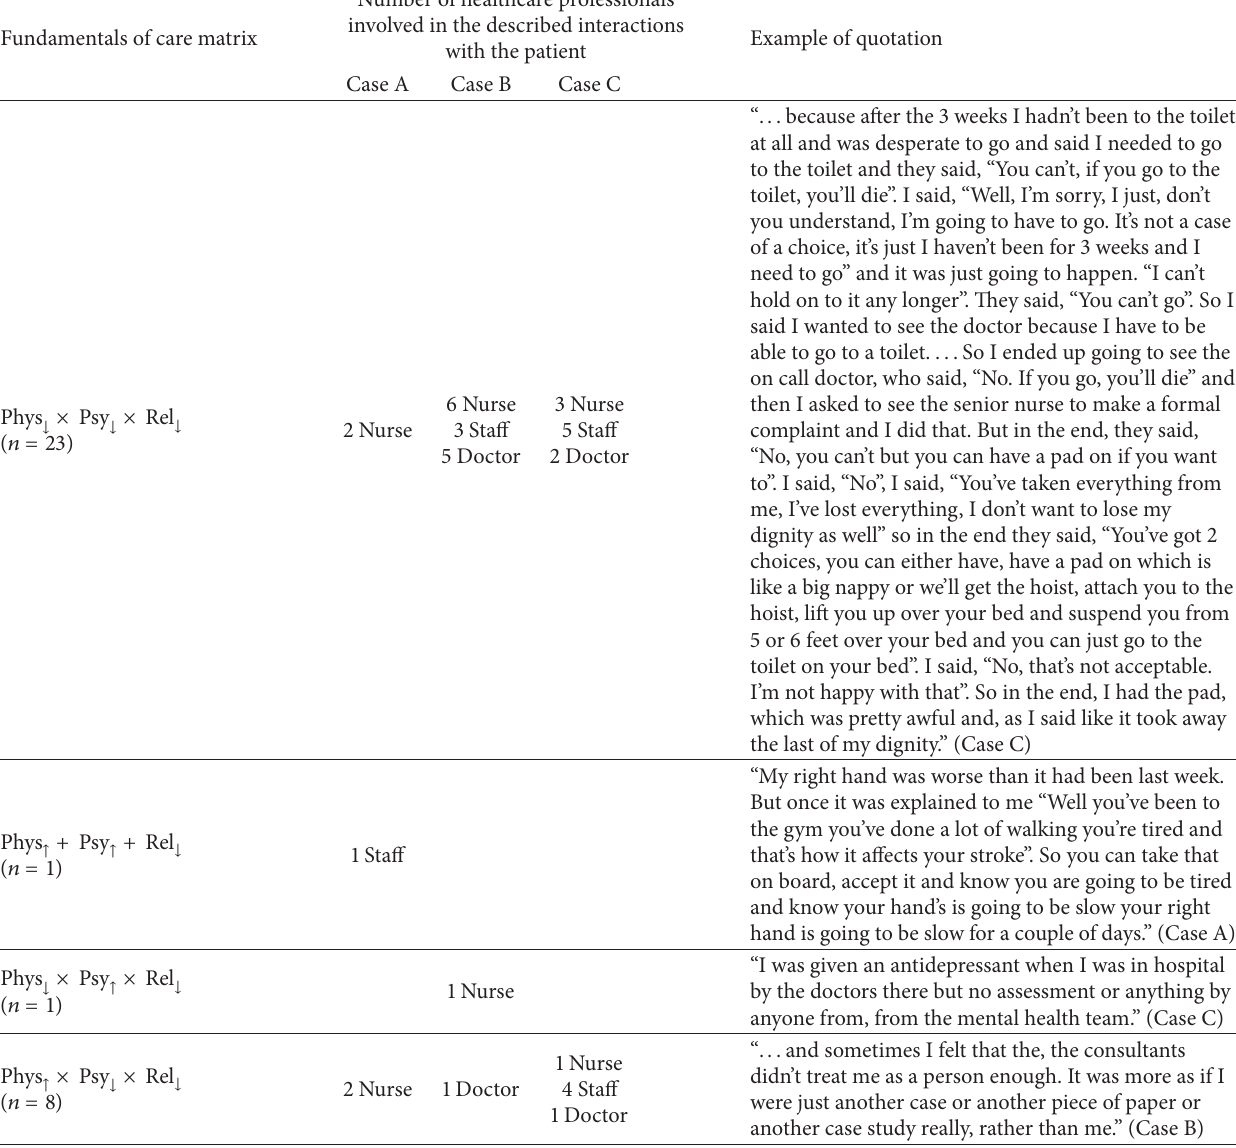
Fundamentals of care